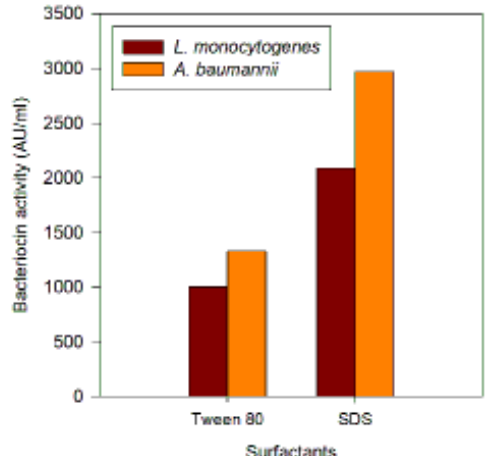
Fig. 10. Effect of surfactants on partially purified bacteriocin